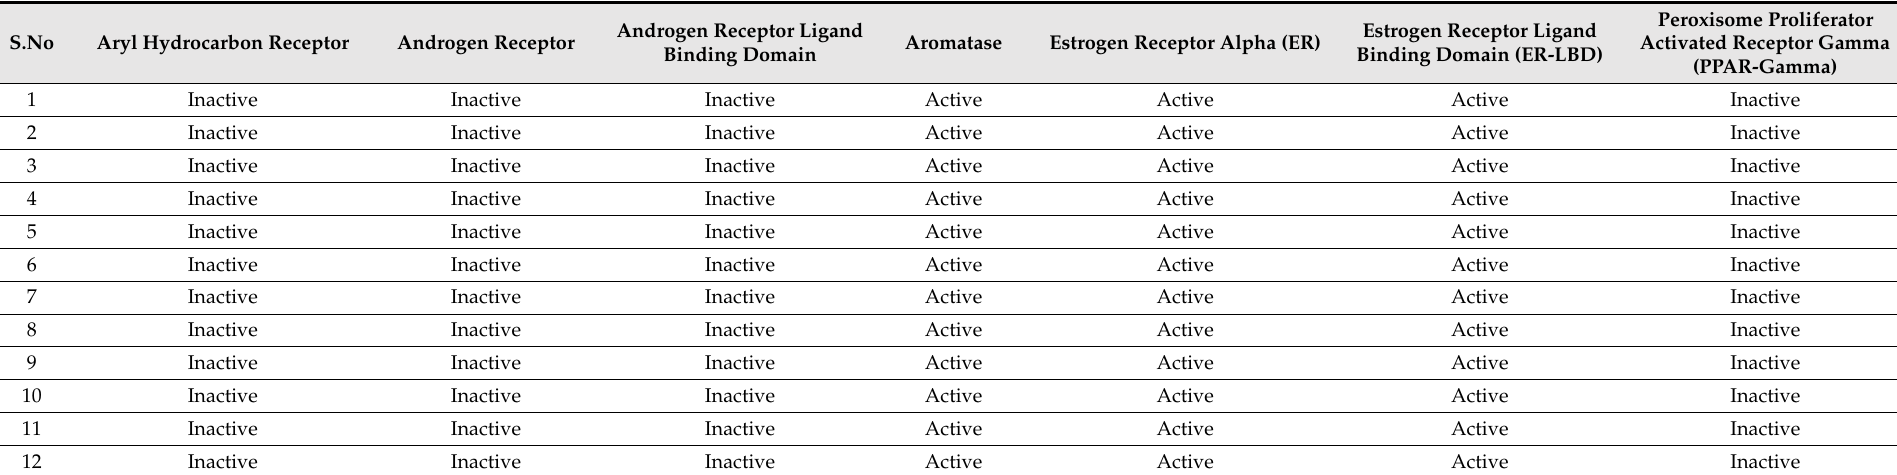
Table 7. Effect of predicted compounds on nuclear signaling pathways predicted using ProTox-II.